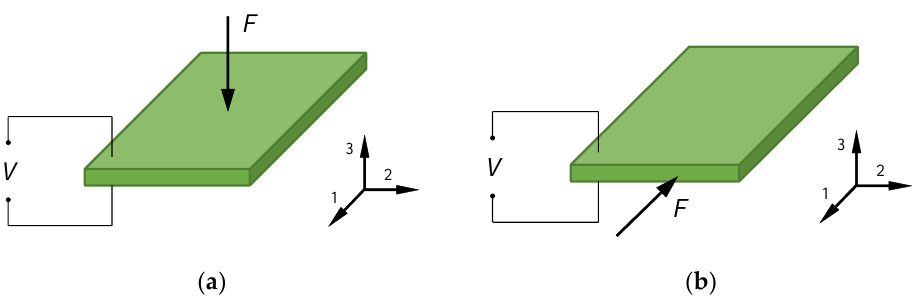
Figure 8. Working modes of piezoelectric material: ( a ) d 33 and ( b ) d 31 modes.